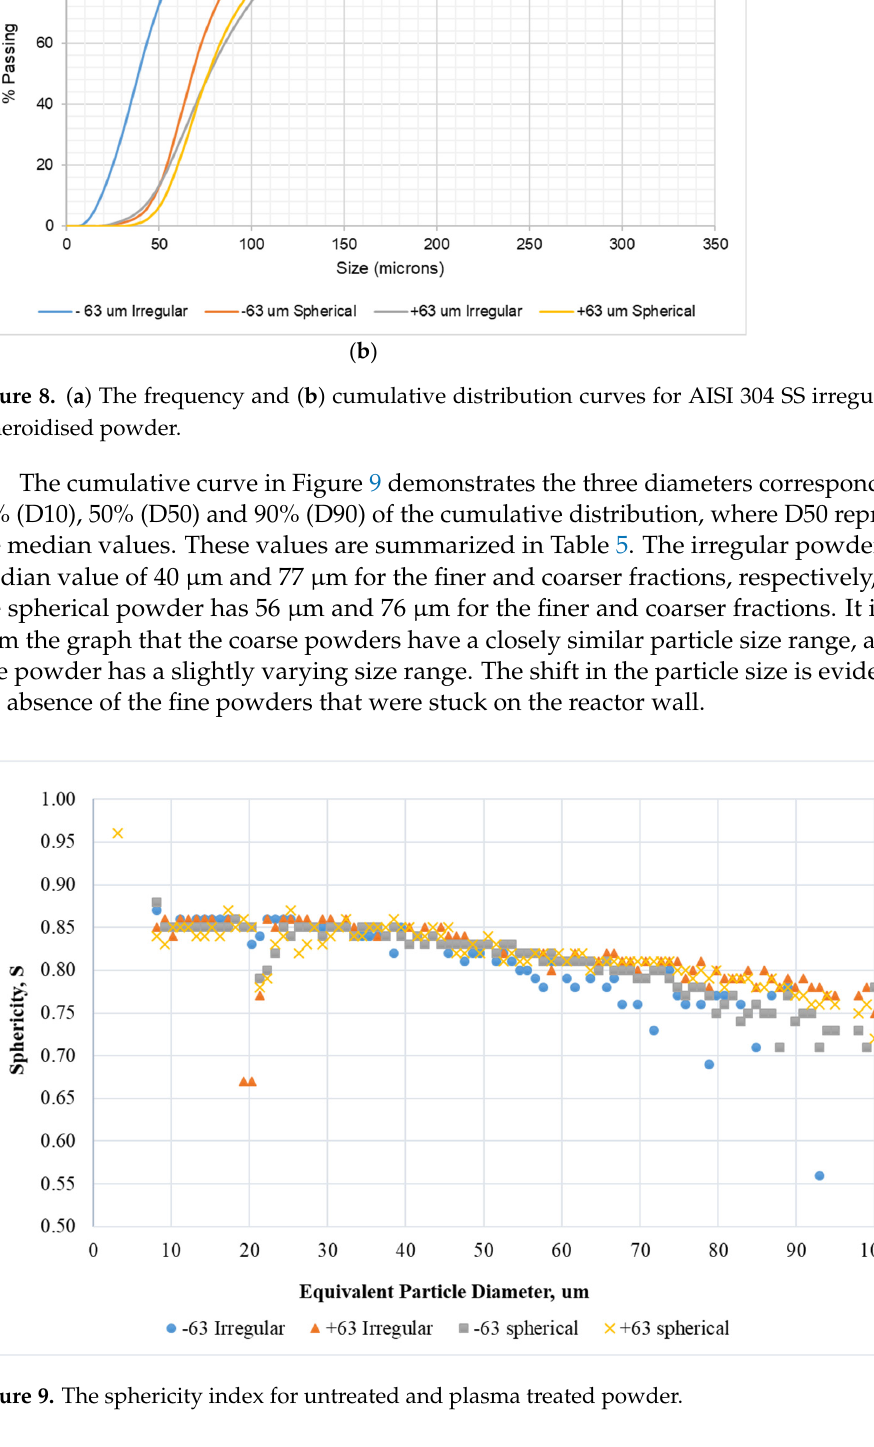
Figure 9. The sphericity index for untreated and plasma treated powder. Table 5. The summary of the powder distribution and shape of the spheroidised powder.